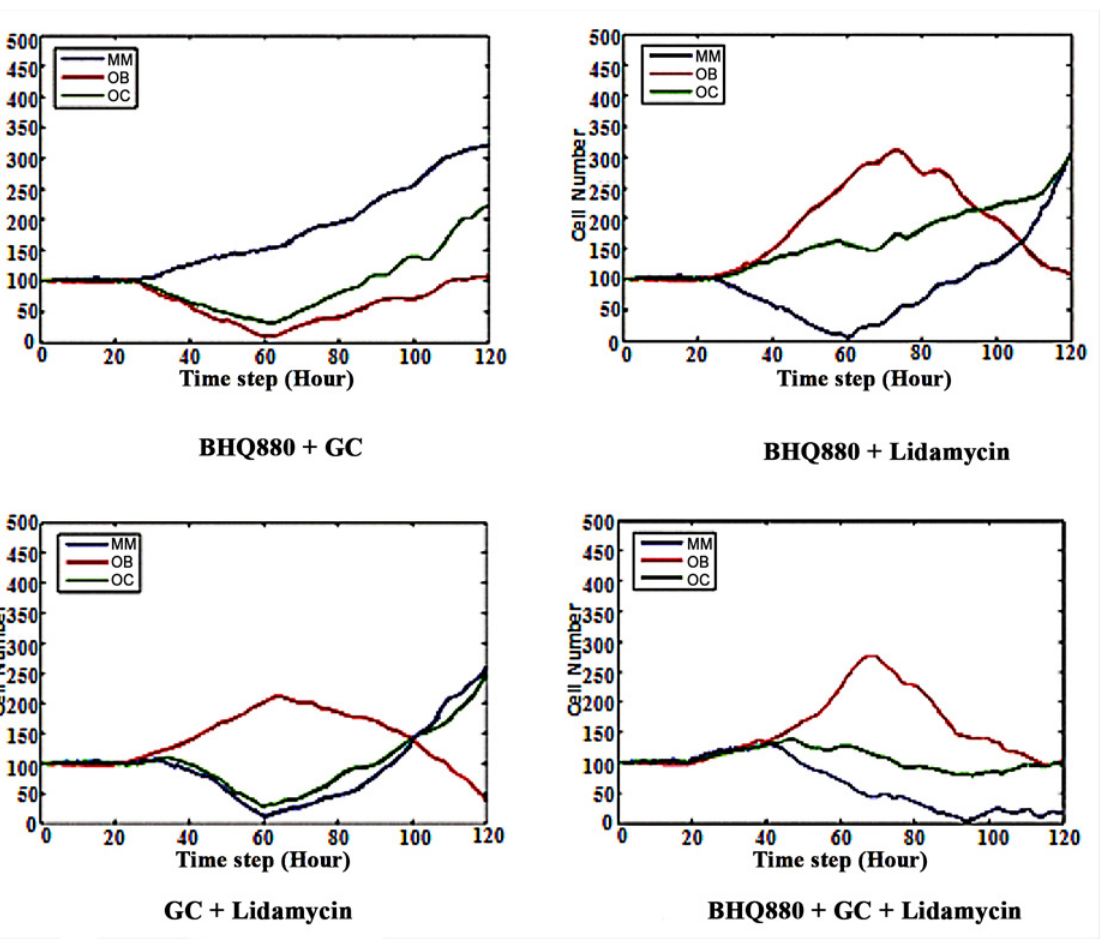
Fig 15. The effect of BHQ880 + GCs, BHQ880 + Lidamycin,GCs + Lidamycin, and BHQ880 + GCs + Lidamycin on the number of OBs, OCs and MMs.